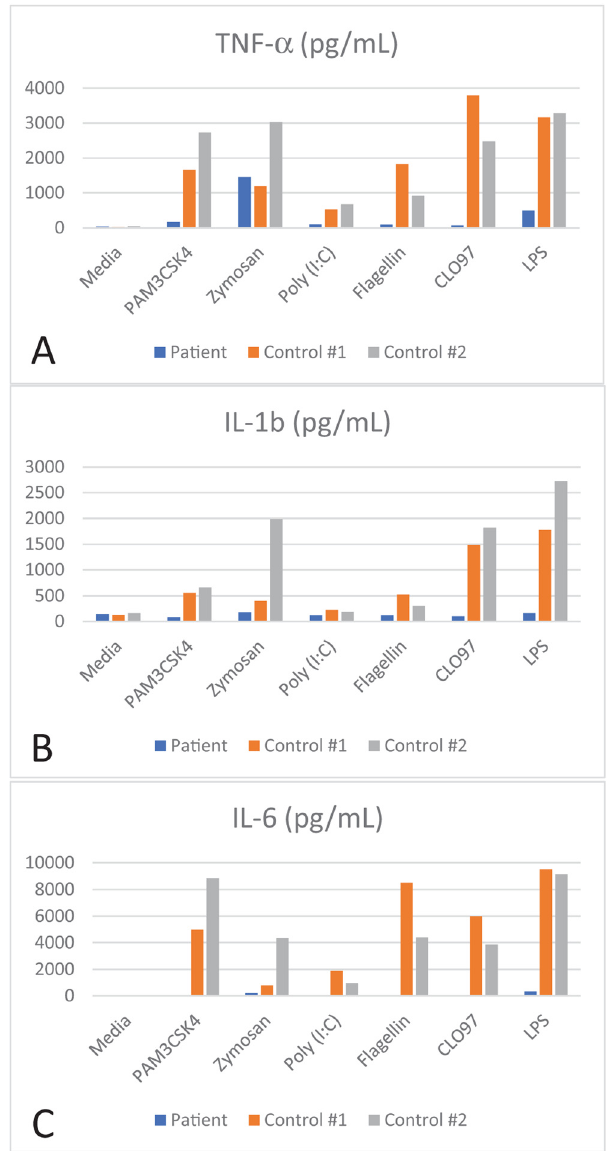
Figure 4. Decreased cytokine response to toll-like receptor (TLR) agonists: A ) TNF alpha, B ) IL-1b, and C ) IL-6 was measured following peripheral blood mononuclear cell (PBMC) stimulation with PAM3CSK4 (TLR2 and TLR1), zymosan (TLR2 and TLR6), Poly (I:C) (TLR3), flagellin (TLR 5), CLO97 (TLR7 and TLR8), and LPS (TLR4).